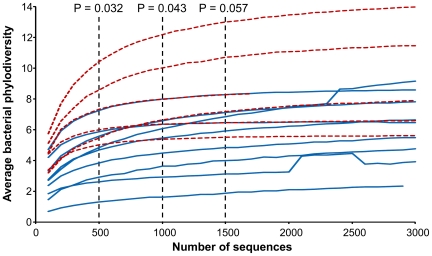
Rarefaction curves showing average bacterial diversity from poorly attractive (PA,) and highly attractive (HA) individuals.
P-value for the difference in diversity score between PA (dashed red line) and HA (solid blue line) individuals is given at three sampling depths (not calculated for higher numbers of sequences, because the samples from some individuals did not yield more than 1500 sequences).